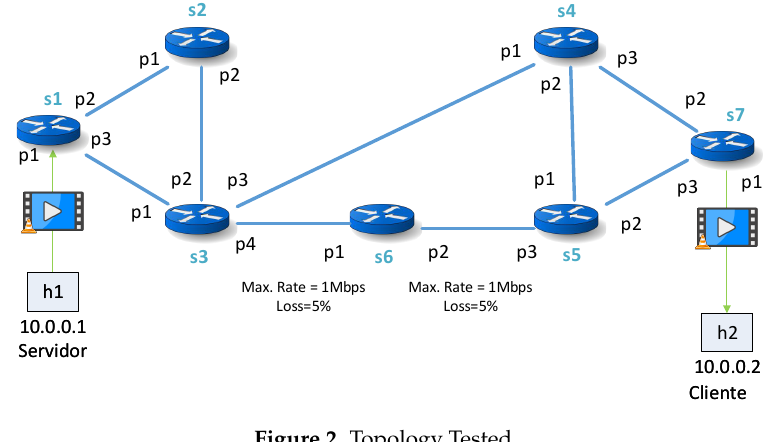
Figure 2. Topology